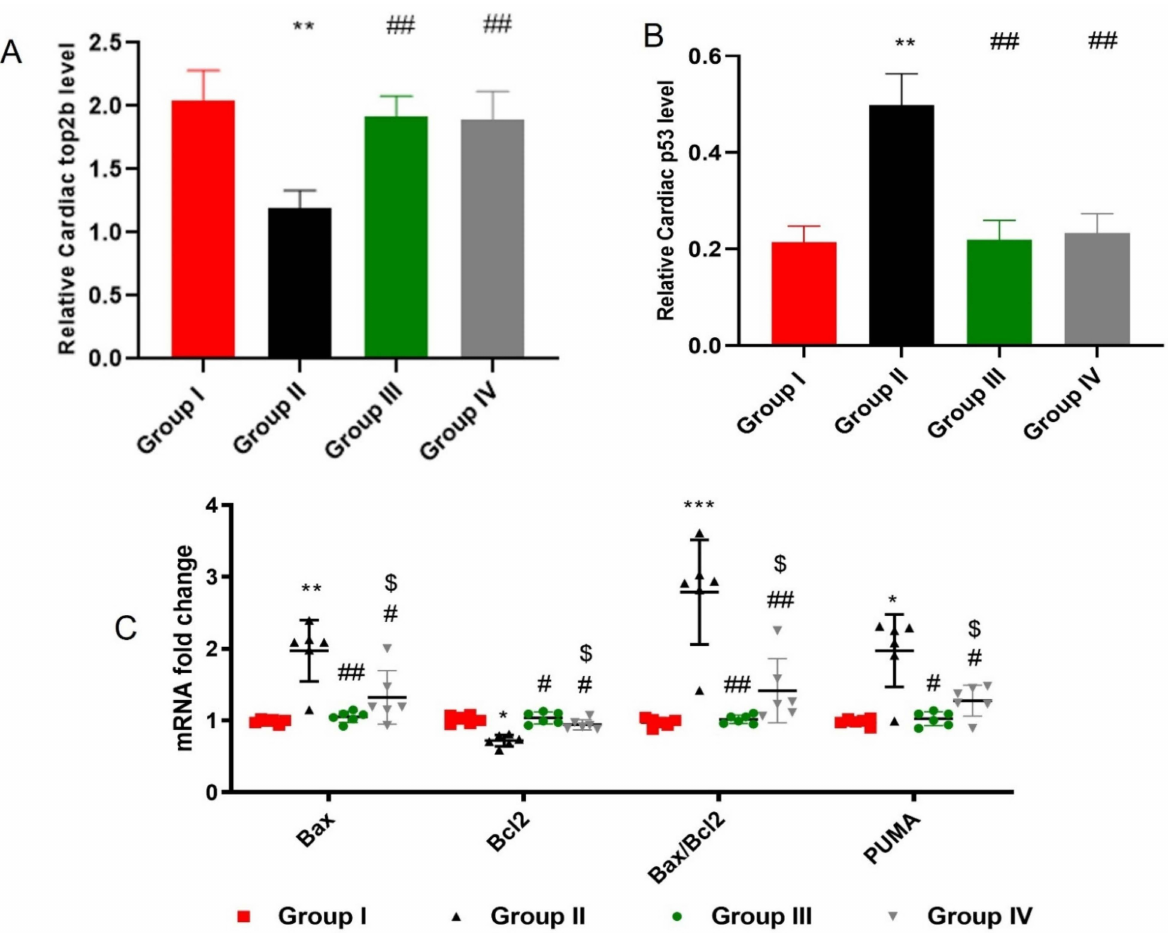
Figure 5. Effect of ADMSCs-derived exosomes on DOX/Trz-induced cardiac DNA damage and apoptosis: ( A ) Topoisomerase 2 beta (Top2b) and ( B ) p53 concentration by ELISA. Results are expressed as mean ± SEM; and ( C ) mRNA levels of cardiac Bax, Bcl-2, Bax/Bcl2 ratio, and PUMA. Data are expressed as median (maximum, minimum). *, significant compared to Group I at p < 0.05; **, significant compared to Group I at p < 0.01; ***, significant compared to Group I at p < 0.001; #, significant compared to Group II at p < 0.05; ##, significant compared to Group II at p < 0.01; $, significant compared to Group III at p < 0.05; n =